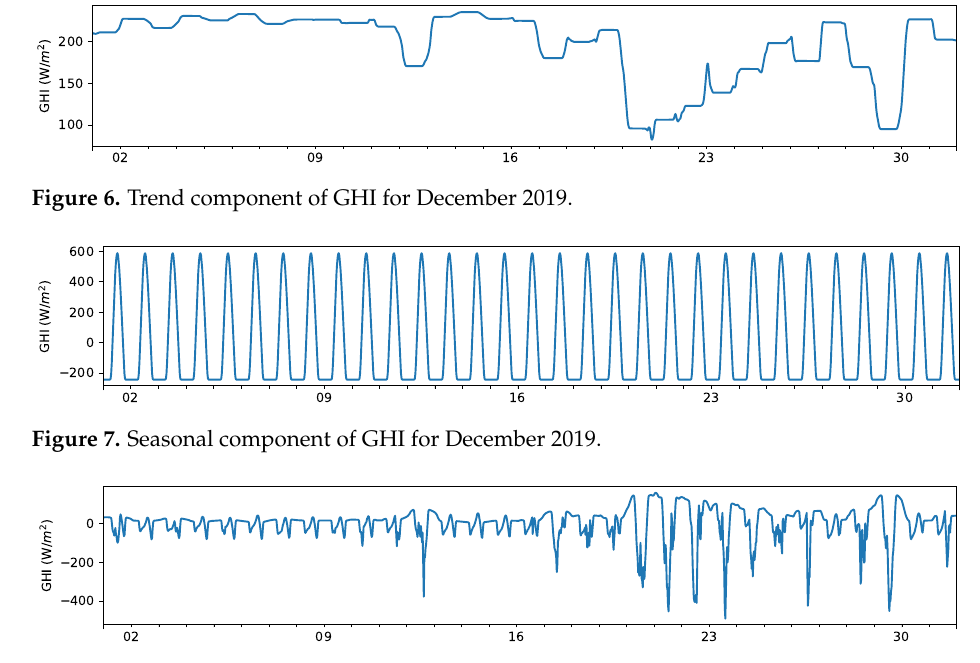
Figure 8. Residual component of GHI for December 2019.